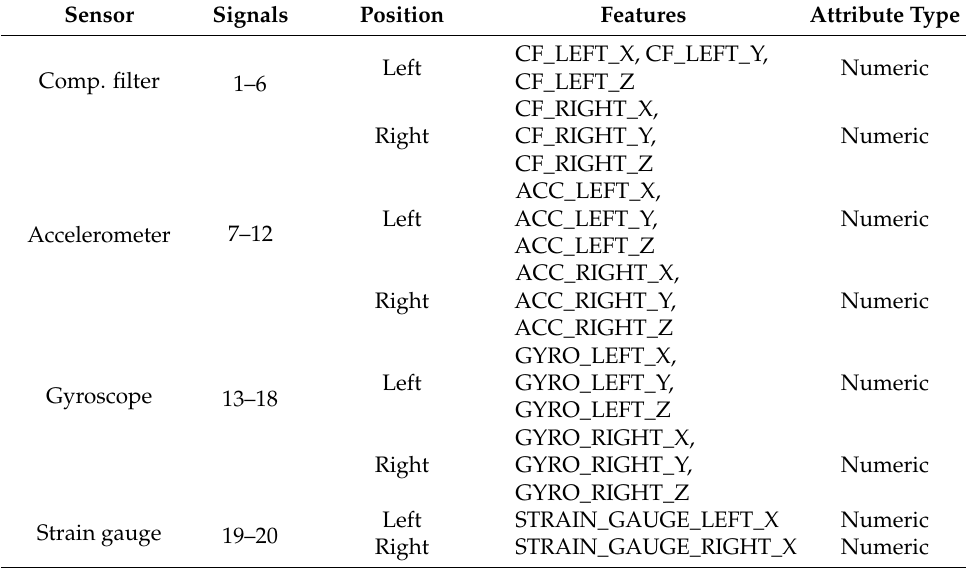
Table 1. Features and their